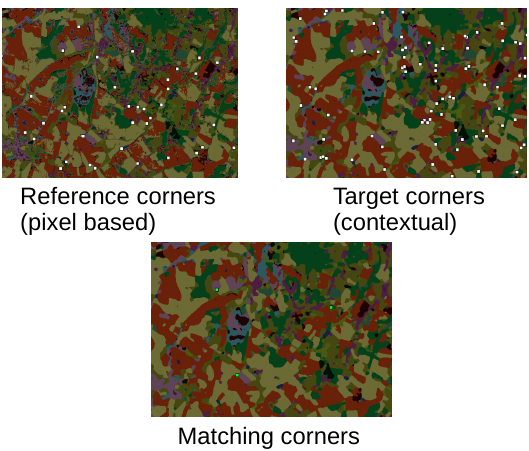
Figure 3. Corner matching. The corner detection is applied on a pixel-based classification, called the reference, and on a contextual classification, called the target. The PBCM is the ratio of matched corners to the number of corners in the